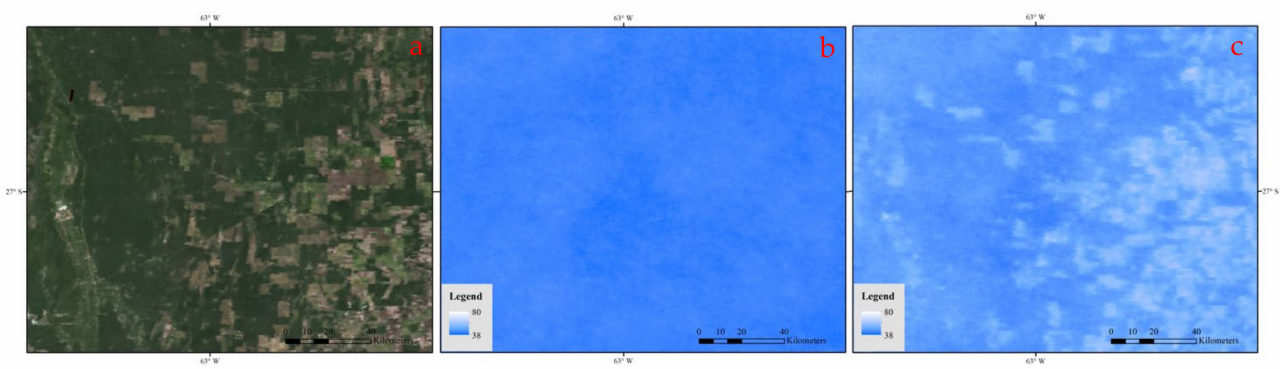
Figure 11. Annual mean cloud frequency (%) over Taihu Lake in 2001 based on Collection 5 of MOD09 cloud mask ( a ) and Collection 6 of MOD35 cloud mask ( b ).